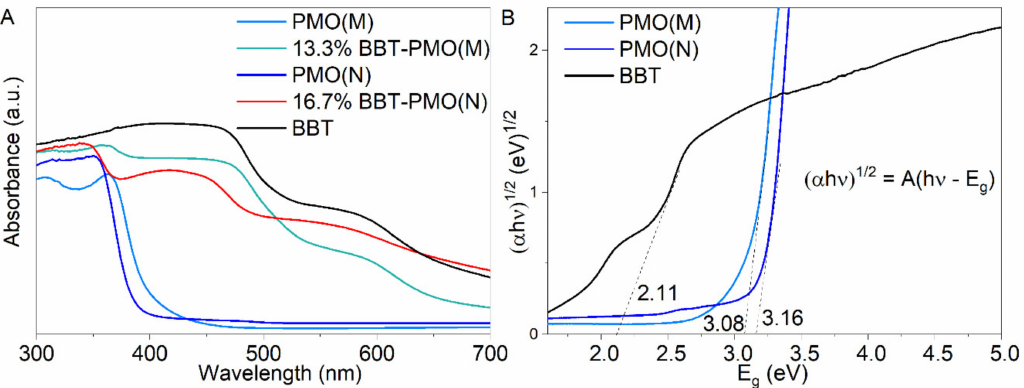
Figure 9. ( A ) UV-vis DRS of BBT, PMO(M), 13.3% BBT-PMO(M), PMO(N), and 16.7% BBT-PMO(N). ( B ) Tauc plots of BBT, PMO(M), and